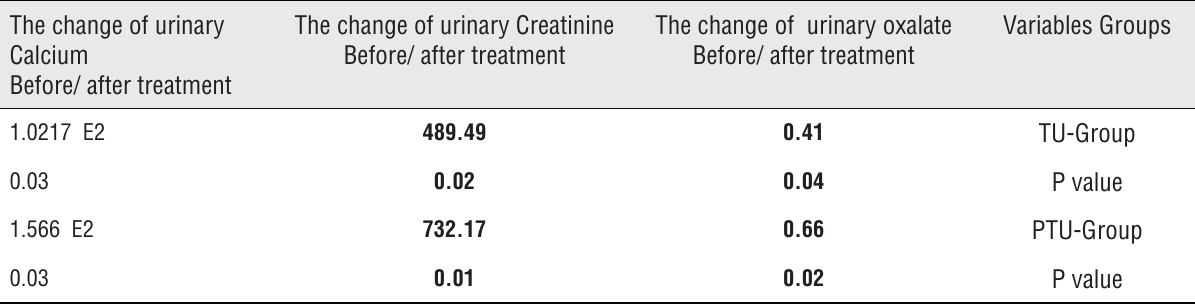
Table 4 - The change of urine oxalate, urine creatinine and the level of urinary calcium before and after the administration of plant extracts and